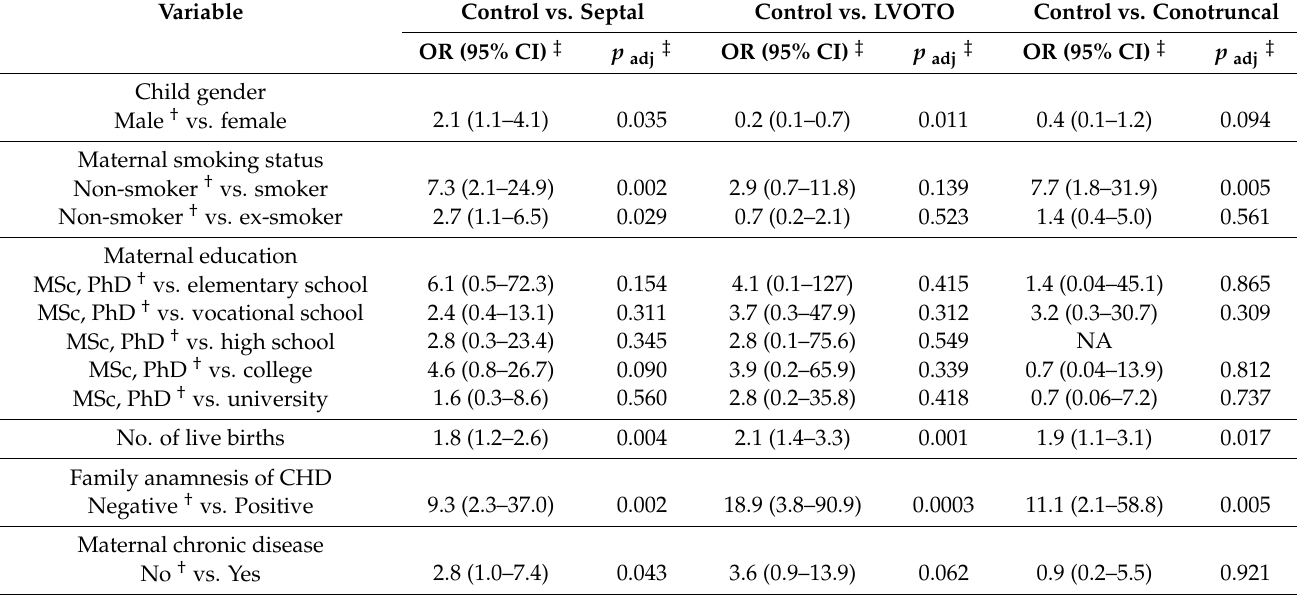
Table 2. Multinomial logistic regression models of selected environmental risk factors in the control and congenital heart defect (CHD) sub-groups (septal, left ventricular outflow tract obstruction [LVOTO], and conotruncal). OR, odds ratio; CI, confidence interval. Control vs. Septal Control vs. LVOTO Control vs.